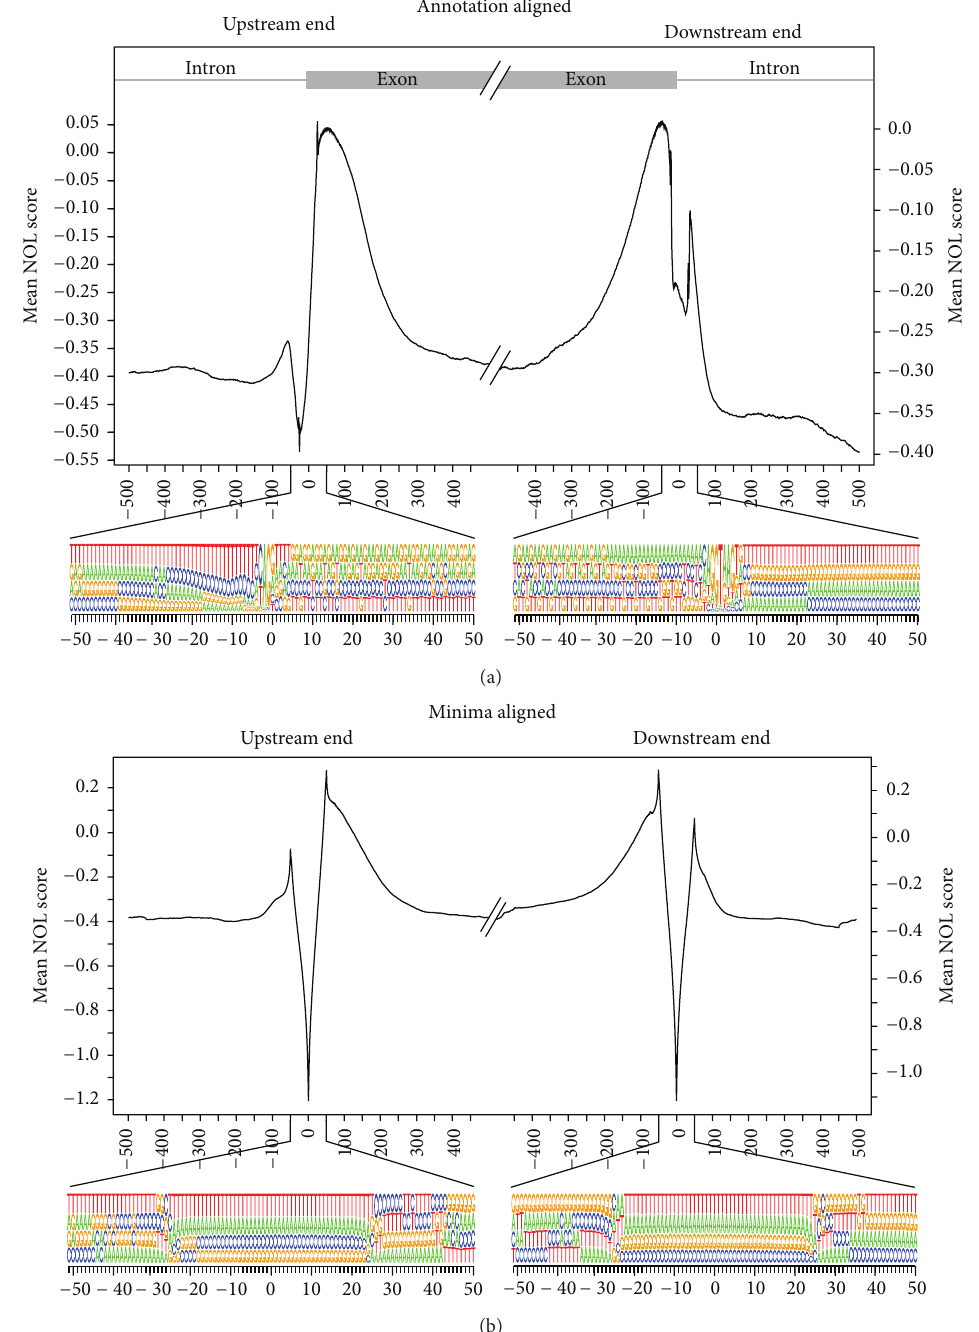
Figure 1: Mean nucleosome occupancy likelihood (NOL) scores for aligned sequences at the boundaries between introns and exons. (a) Mean NOL scores for the regions +/ − 500bp from the annotated upstream end and downstream end of the exons. For the central region +/ − 50bp, nucleotide representation at each position is indicated by the size of the letters. (b) Mean NOL scores and associated nucleotide representations for the regions centered on the minimum value found within +/ − 50bp of the annotated boundary between intron and